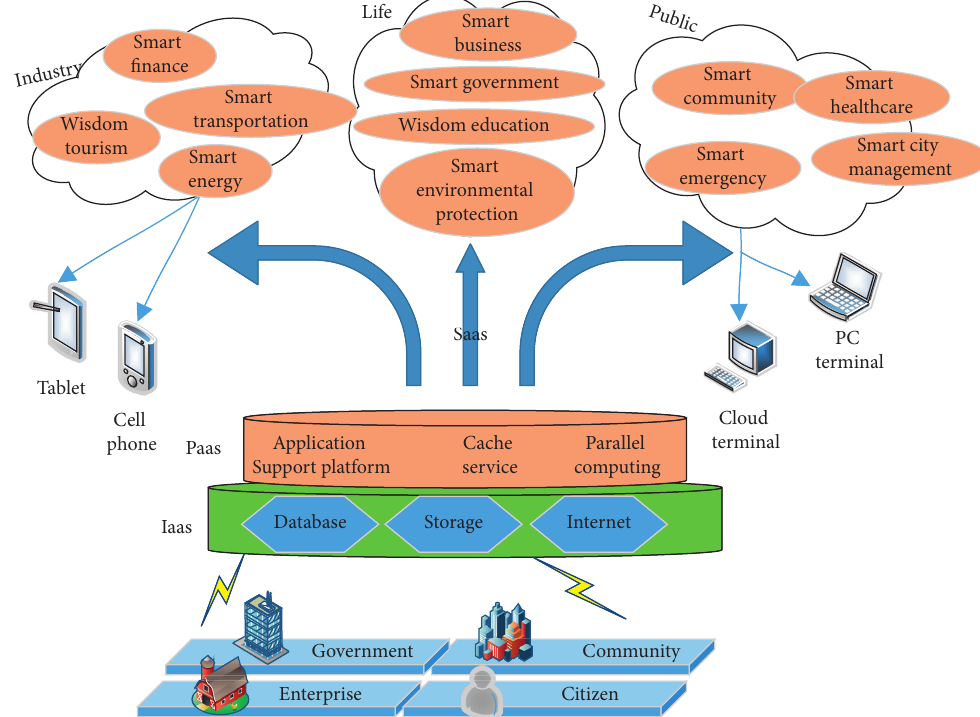
Figure 1: Smart city